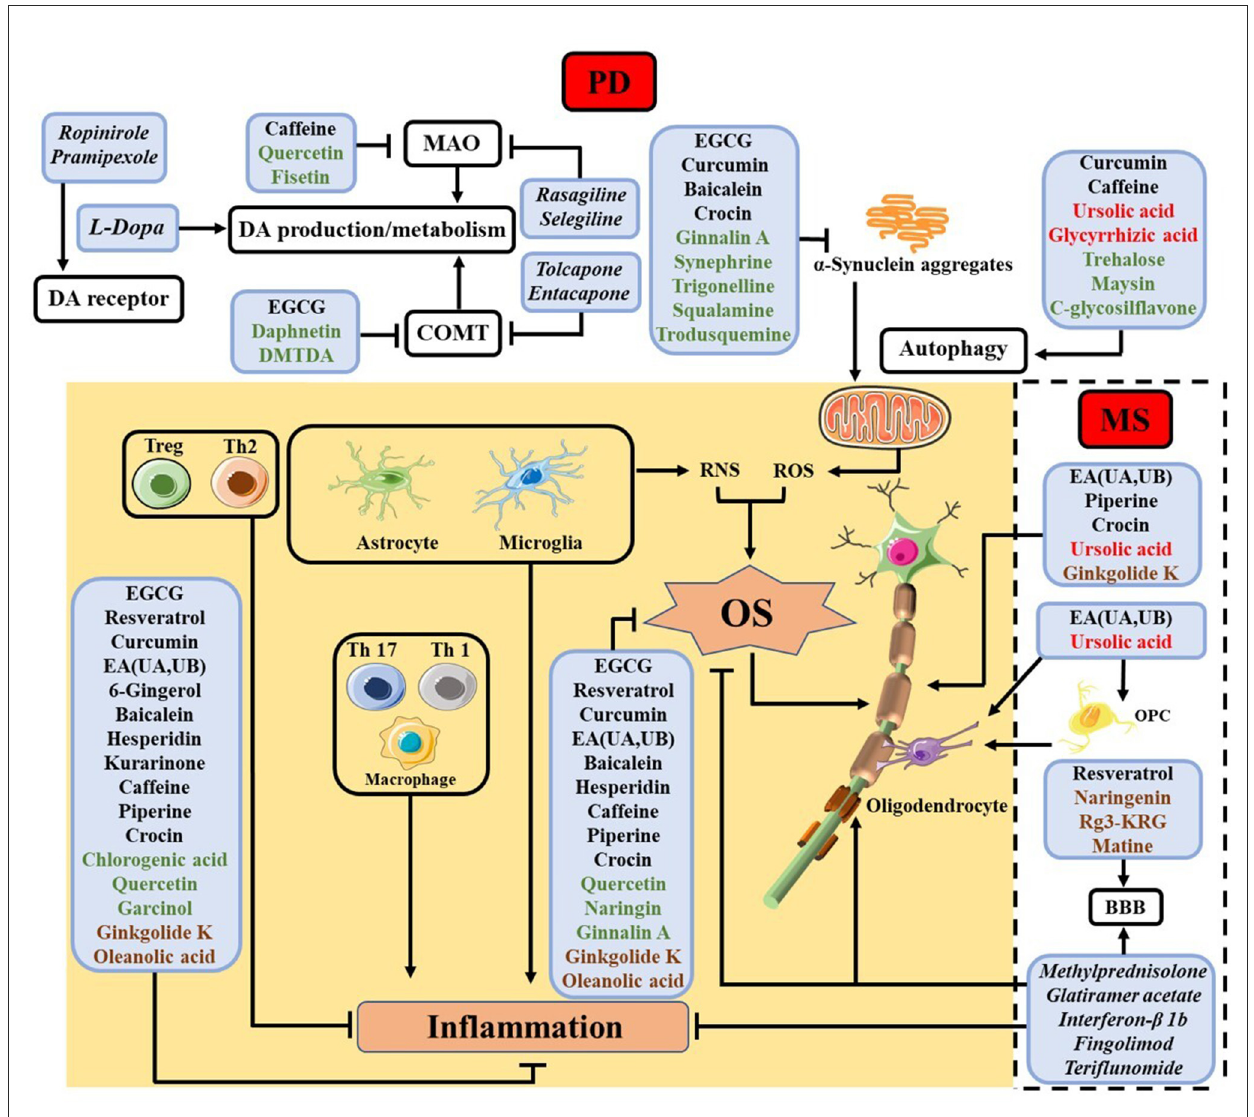
FIGURE2 Summary of NPs studied for different cellular processes in PD and MS, with the names of NPs used for the same and different processes in PD and MS shown in black and red, respectively. NPs studied thus far only for PD are shown in green, while those only for MS in brown. The shaded area contains processes related to inflammation and OS common in both diseases, whereas the top unshaded area depicts some extensively studied processes inherent in PD and the unshaded area encircled by the dashed box shows myelin protection and regeneration, which are unique of MS. The names of some clinical drugs targeting different processes are listed in italic. For PD, levodopa (L-Dopa), monoamine oxidase (MAO) inhibitor (rasagiline and selegiline), catechol- O -methyl transferase (COMT) inhibitor (tolcapone and entacapone) and DA agonists (ropinirole and pramipexole) are employed (47). In MS, methylprednisolone, glatiramer acetate, interferon- β 1b, fingolimod, and teriflunomide are used